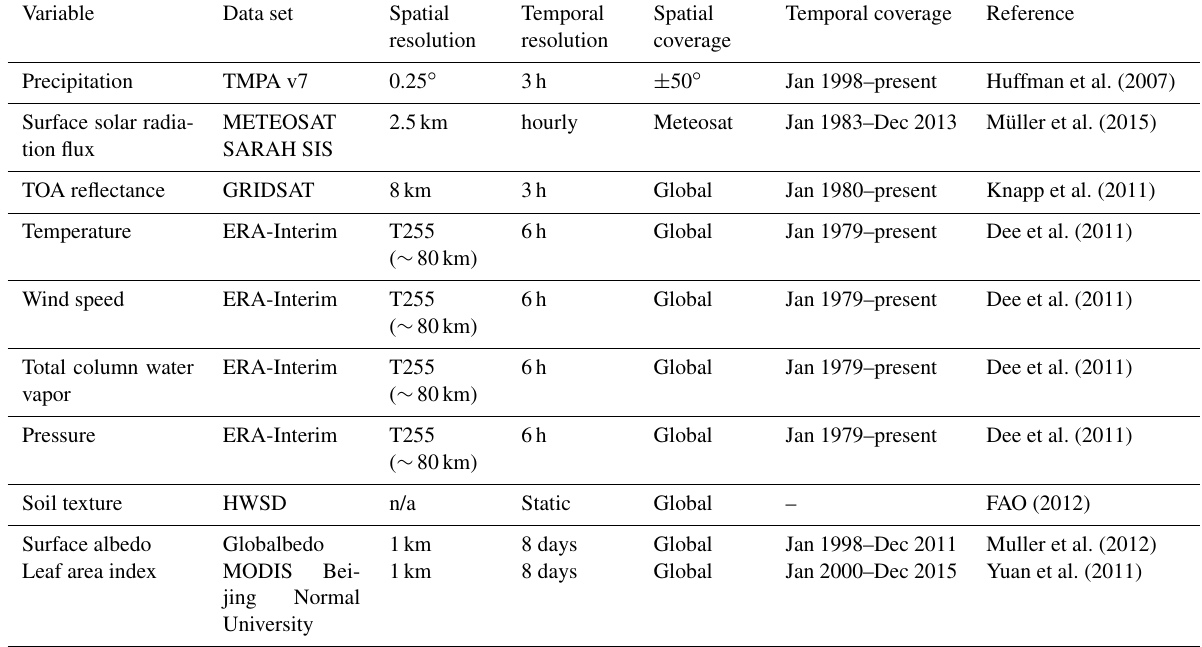
Table 1. Overview of data sets used as drivers for HOLAPS.